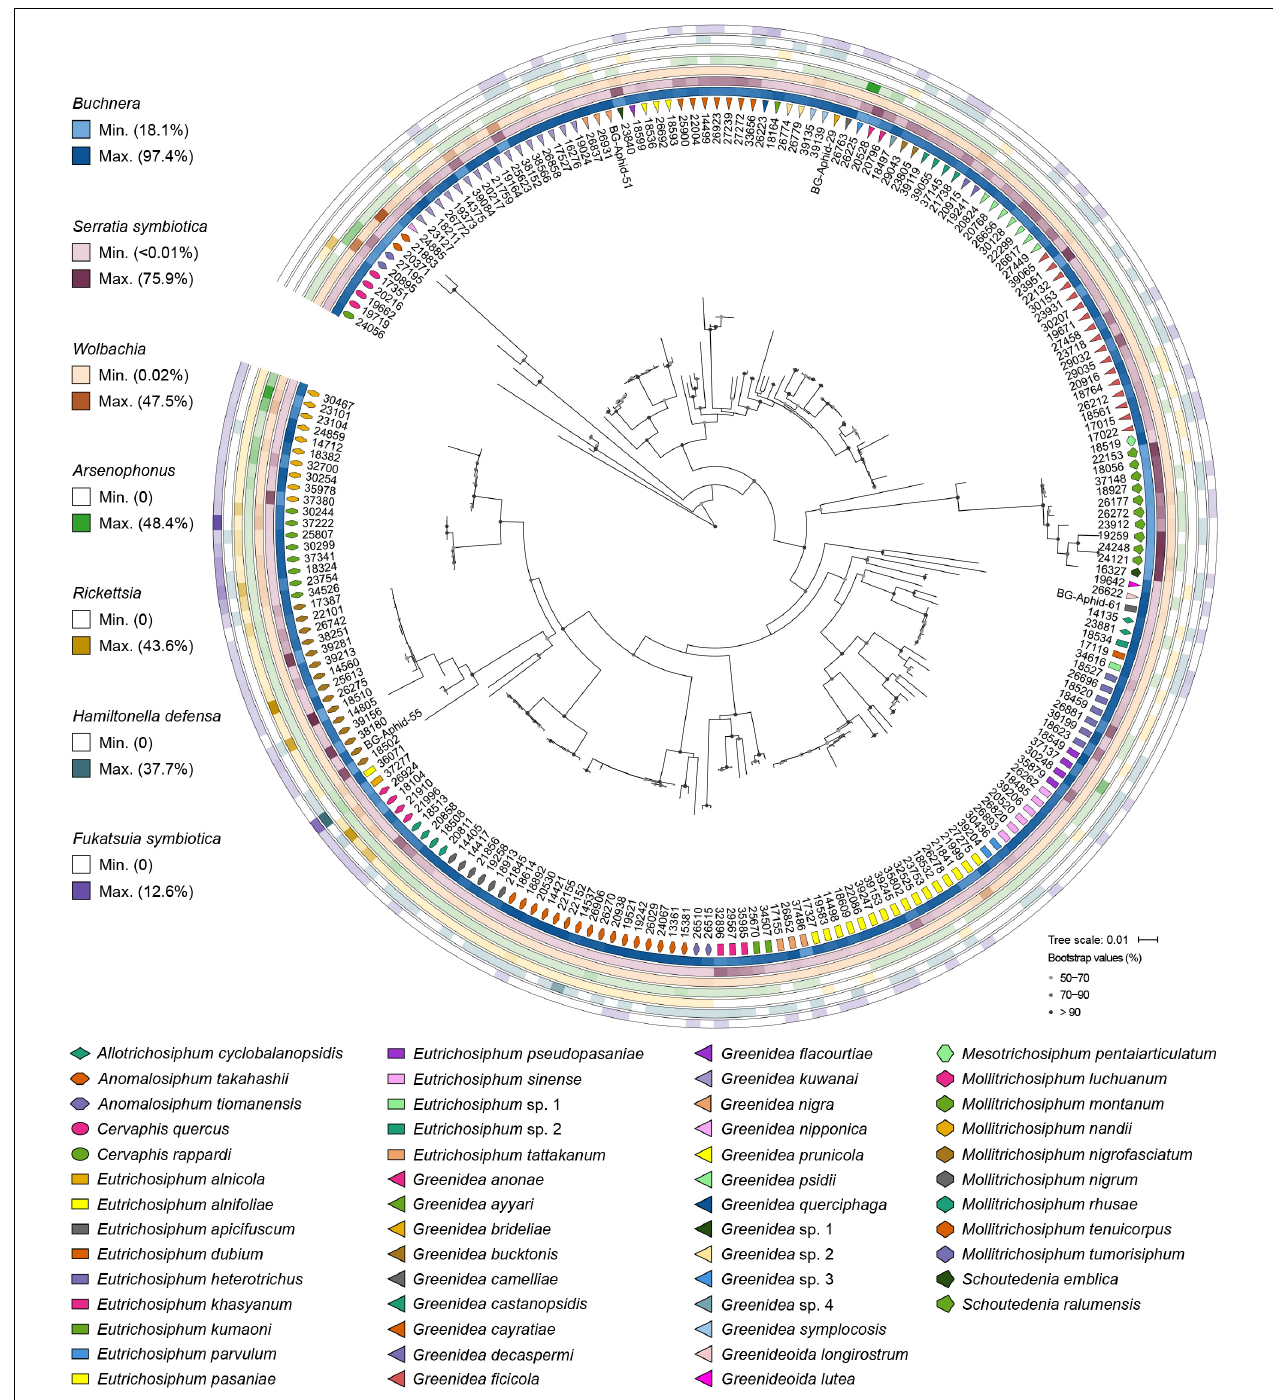
FIGURE 1 | Symbiont community composition shown on the maximum-likelihood tree of Greenideinae aphids. Gray dots on the phylogeny nodes indicate bootstrap support of over 50%.